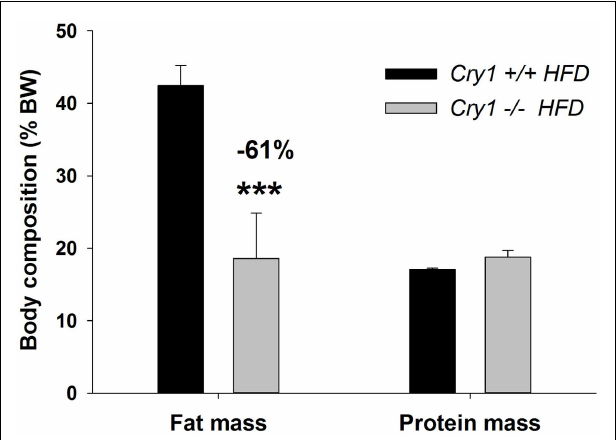
FIGURE 3 | Body composition (% BW) ofWT control and Cry1 -deficient mice . Fat and protein masses (% body weight) forWT control Cry1 + / + ( filled bars ) and Cry1 − / − ( open bars )-deficient mice, determined on a HFD regimen. Cry1 group: n = 4 ( Cry1 + / + -STD) and 5 ( Cry1 − / − -STD) and n = 8 ( Cry1 + / + -HFD) and 6 ( Cry1 − / − -HFD). One-way ANOVA for body composition. *** P < 0.001 significant difference for body composition of each strain. Values shown are mean ± SEM.